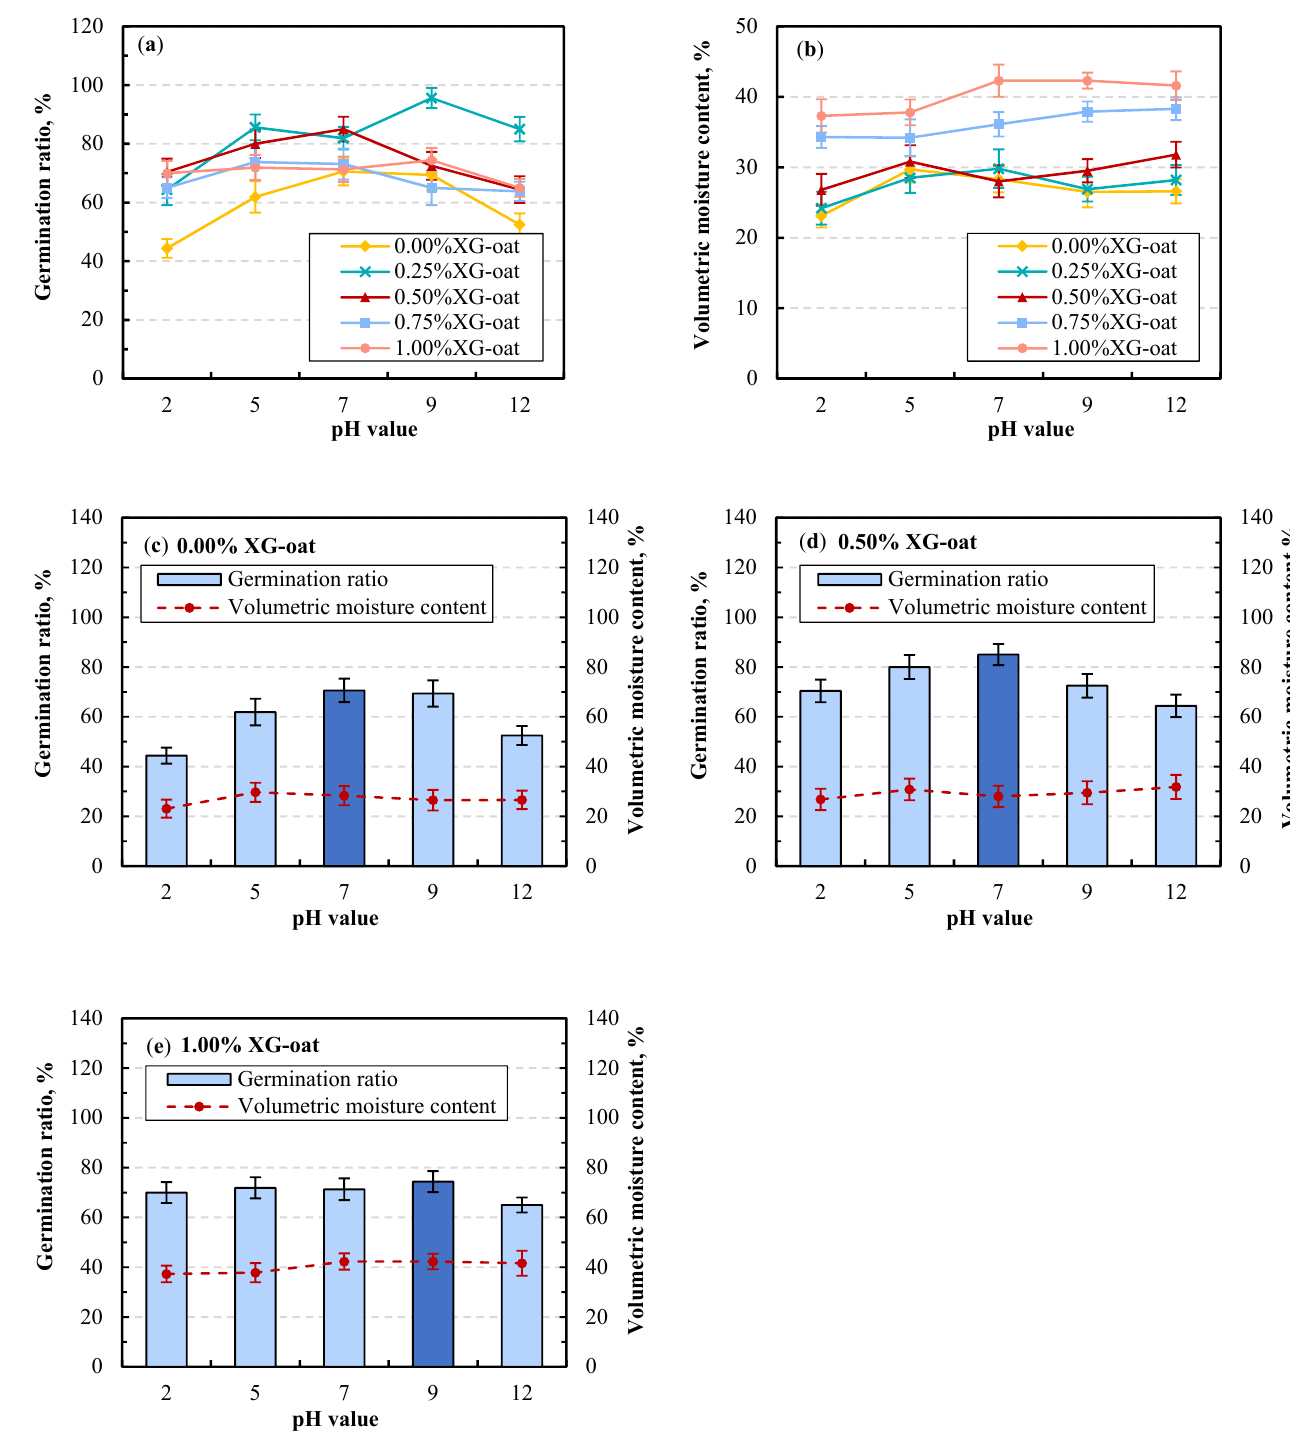
Figure 11. ( a ) Germination ratio versus pH value; ( b ) volumetric moisture content versus pH value; ( c ) germination ratio and volumetric moisture content versus pH value (0.00% XG–oat); ( d ) germination ratio and volumetric moisture content versus pH value (0.50% XG–oat); ( e ) Germination ratio and volumetric moisture content versus pH value (1.00% XG–oat).